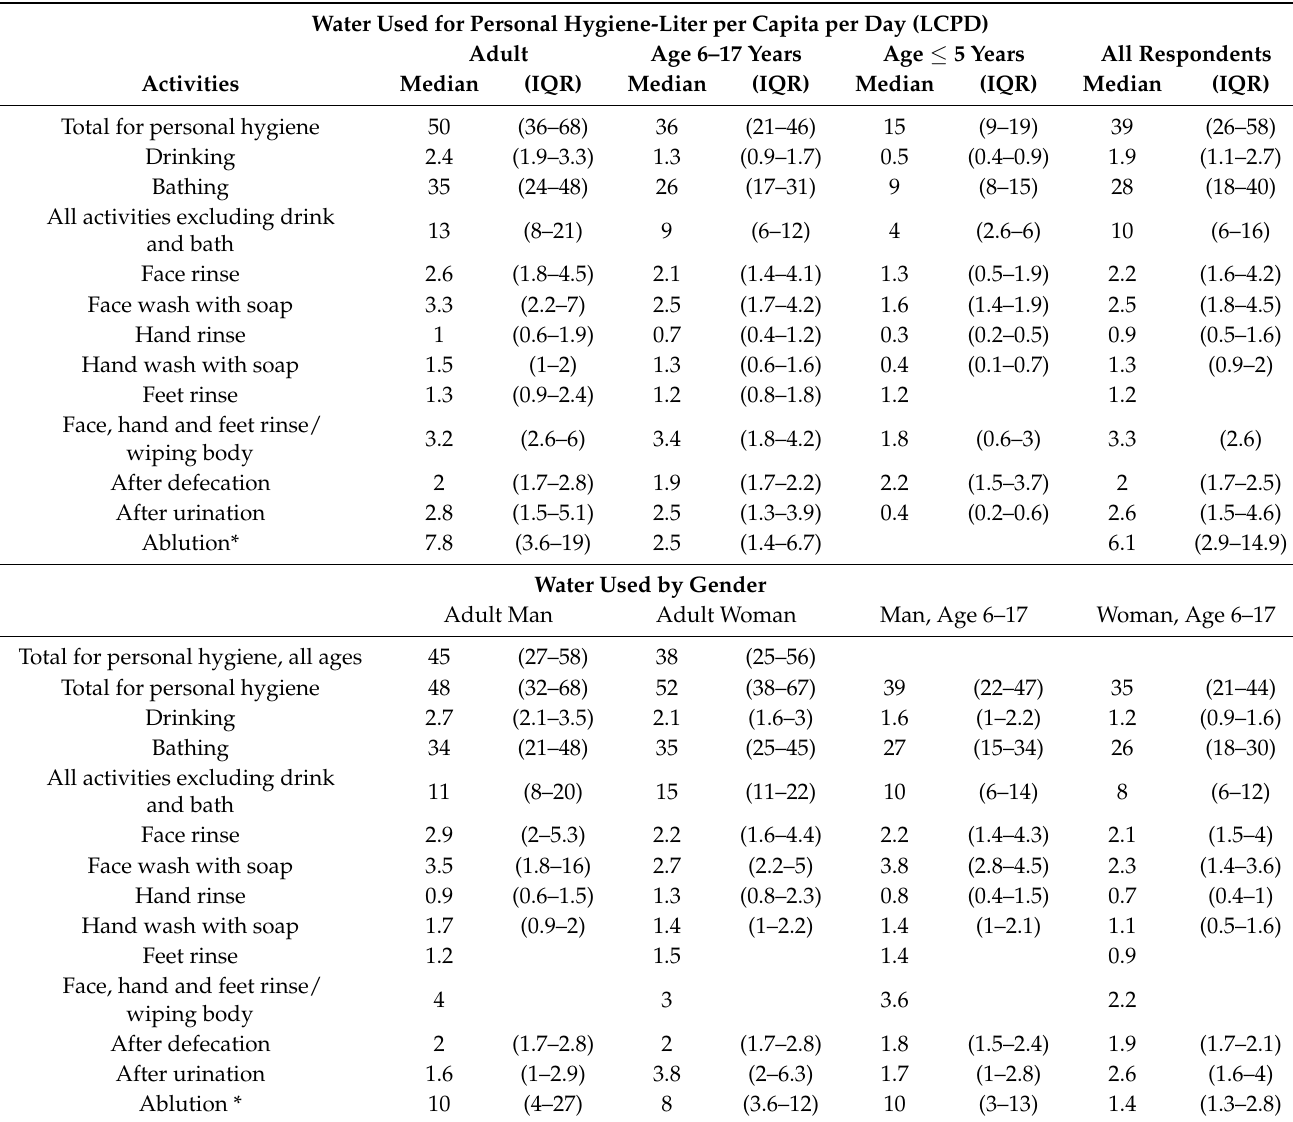
Table 2. Volume of water used for personal hygiene among the low-income urban residents of Arichpur, Dhaka, from May 2015 to March